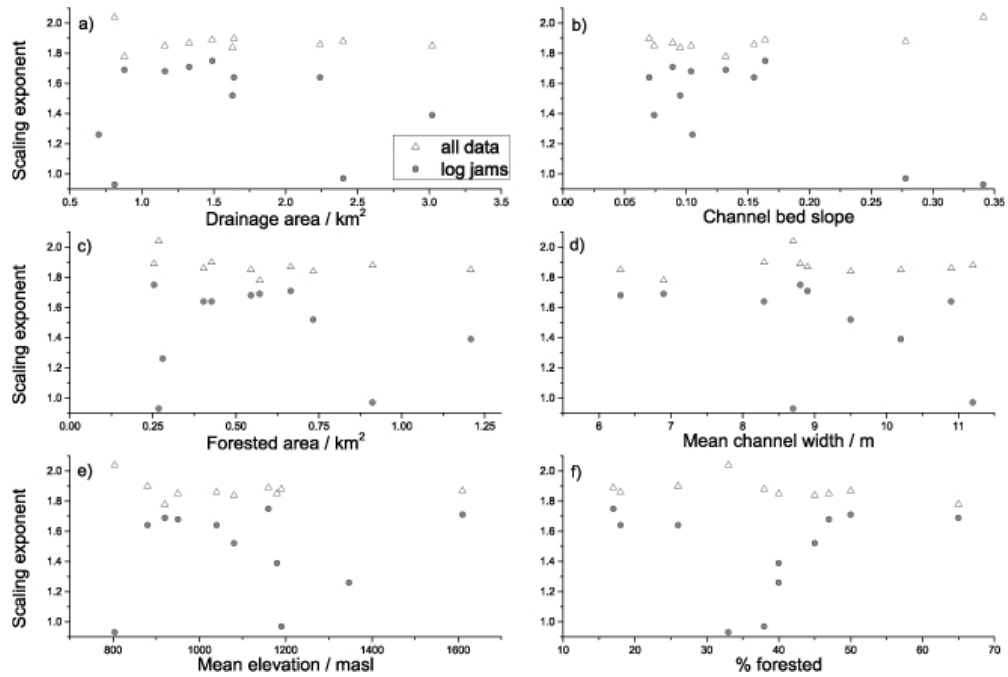
Figure 8. Scaling exponents of eleven Swiss mountain streams (Table 1) as functions of (a) drainage area, (b) channel bed slope, (c) forested area, (d) mean channel width, (e) mean elevation above sea level, and (f) percent fraction of the catchment covered by forest. Note that the two lowest scaling exponents for log jam material at 0.93 and 0.97, corresponding to the Brüggenwaldbach and Grossbach (Table 1), are based on a small number of measurement and are probably spurious. No strong correlations or trends are obvious.